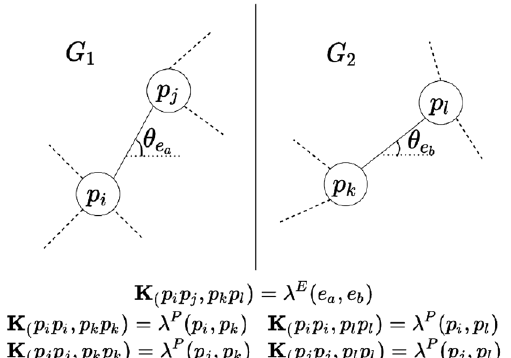
Figure 3. Two nodes in G 1 and G 2 . The element values in K are calculated according to Eqs. (4) and